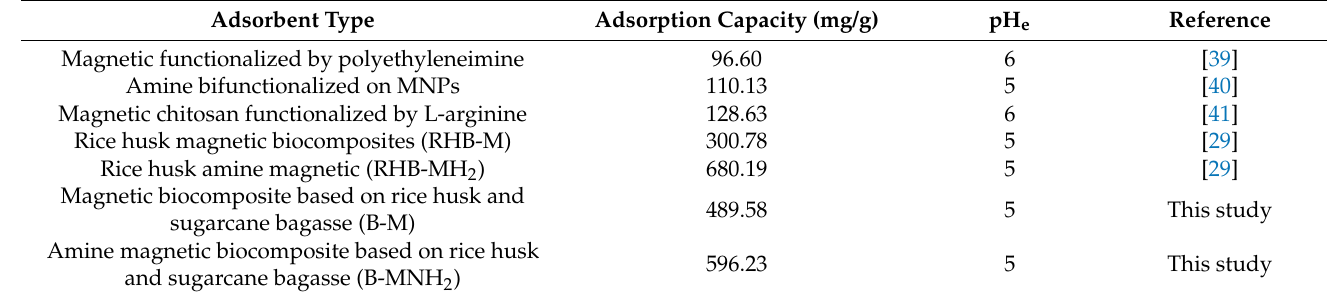
Table 4. Maximum adsorption capacity of Pb(II) ion adsorption on different